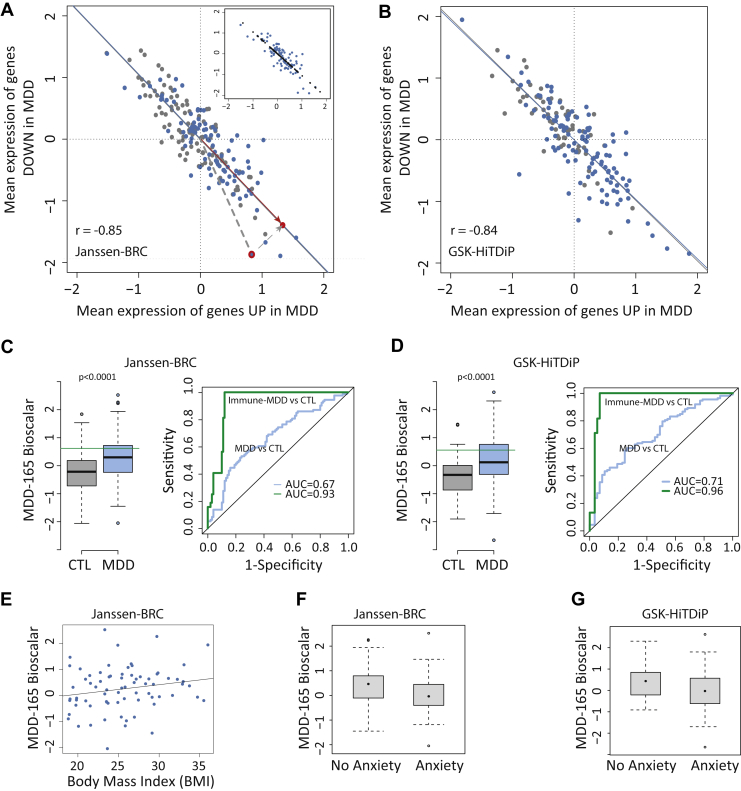
Opposing and coordinated expression of innate and adaptive immune transcripts in patients with major depressive disorder (MDD). (A, B) Scatter plots for the mean expression across the 75 underexpressed (DOWN) genes plotted against the mean expression of 90 overexpressed (UP) genes in the Janssen–Brain Resource Company (Janssen–BRC) (A) and GlaxoSmithKline–High-Throughput Disease-specific target Identification Program (GSK–HiTDiP) (B) datasets. Each point corresponds to a patient. Blue indicates case, and gray indicates control (CTL). Regression lines are shown in blue and gray, respectively. In (A), an individual patient’s data point (red outline) is projected onto the regression line (red circle). The distance from the origin to the point on the regression line is the bioscalar value for that patient. Inset illustrates the projection (black) of all individual patient data points (blue) onto the sample regression line. (C, D) Left panels: Box plot of MDD-165 bioscalar values in controls and cases. Green line indicates the threshold identifying the top third (tertile) of the MDD-165 bioscalar distribution as a subgroup of inflamed patients with MDD (designated immune-MDD). Right panels: Receiver operating characteristic curves were calculated for MDD vs. CTL and immune-MDD vs. CTL classifications. (E) Correlation of each depressed patient’s MDD-165 bioscalar with body mass index (BMI). (F, G) Box plots of MDD-165 bioscalar for subgroups defined by a comorbid diagnosis of anxiety disorder. AUC, area under the curve.